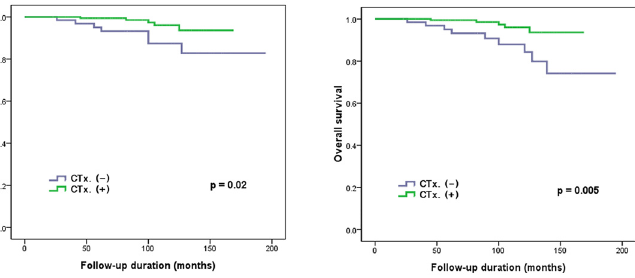
Fig 1. The association between adjuvant chemotherapy (CTx.) and survival (breast cancer-specific survival and overall survival) in all patients.